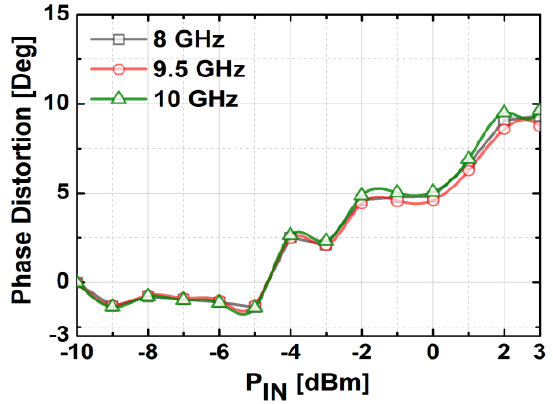
Figure 22. The measured output power and gain of the implemented TRM at different frequencies.